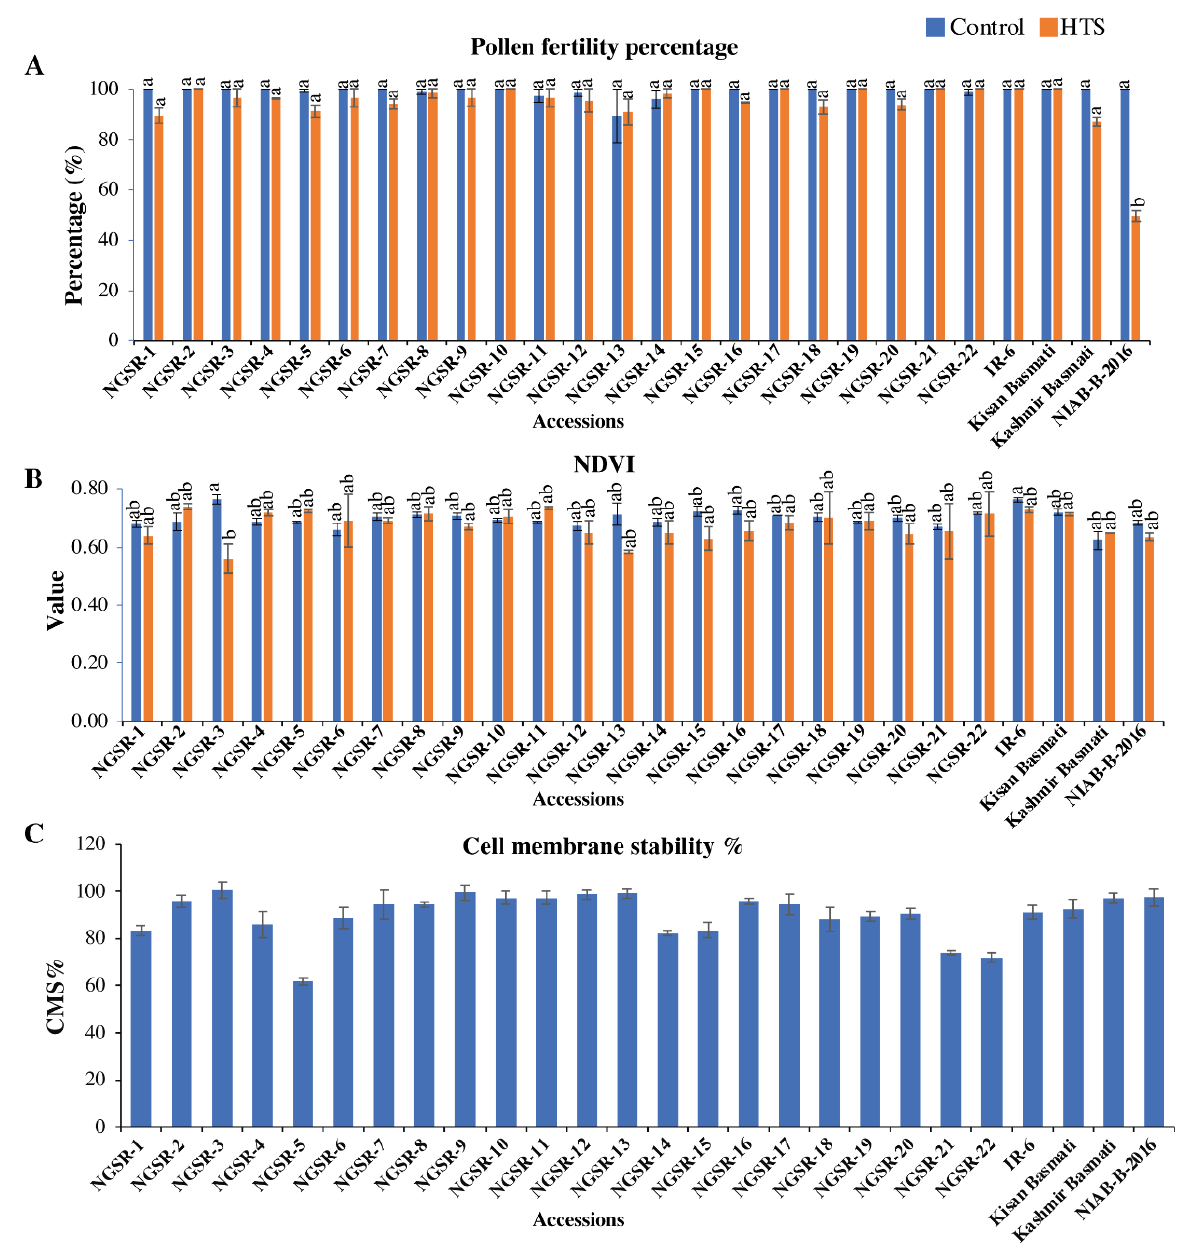
Figure 5. Effect of heat stress on pollen fertility ( A ), NDVI (normalized difference vegetative index, B ), and cell membrane stability (CMS, C ). Data was mean ± SE of three replicates. Tuckey’s test was used for statistical differences. Different letters above the column varied significantly at p < 0.05.